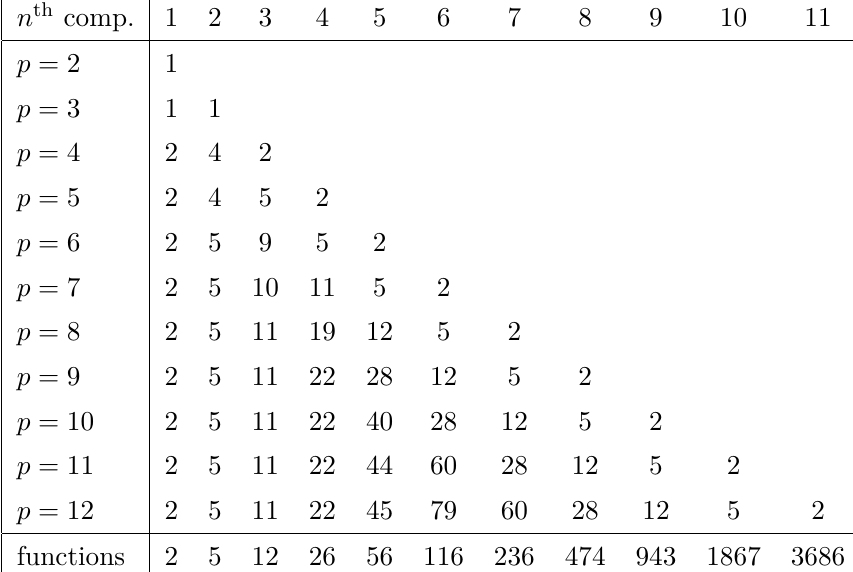
Table 8 . The number of independent { n, 1 , . . . , 1 } coproduct components of all log w coefficients E (6) p of the L = 6 loop NMHV amplitude from eq. (5.2). For the reader’s convenience we copied the total number of DS functions f ( p ) at each weight p from table